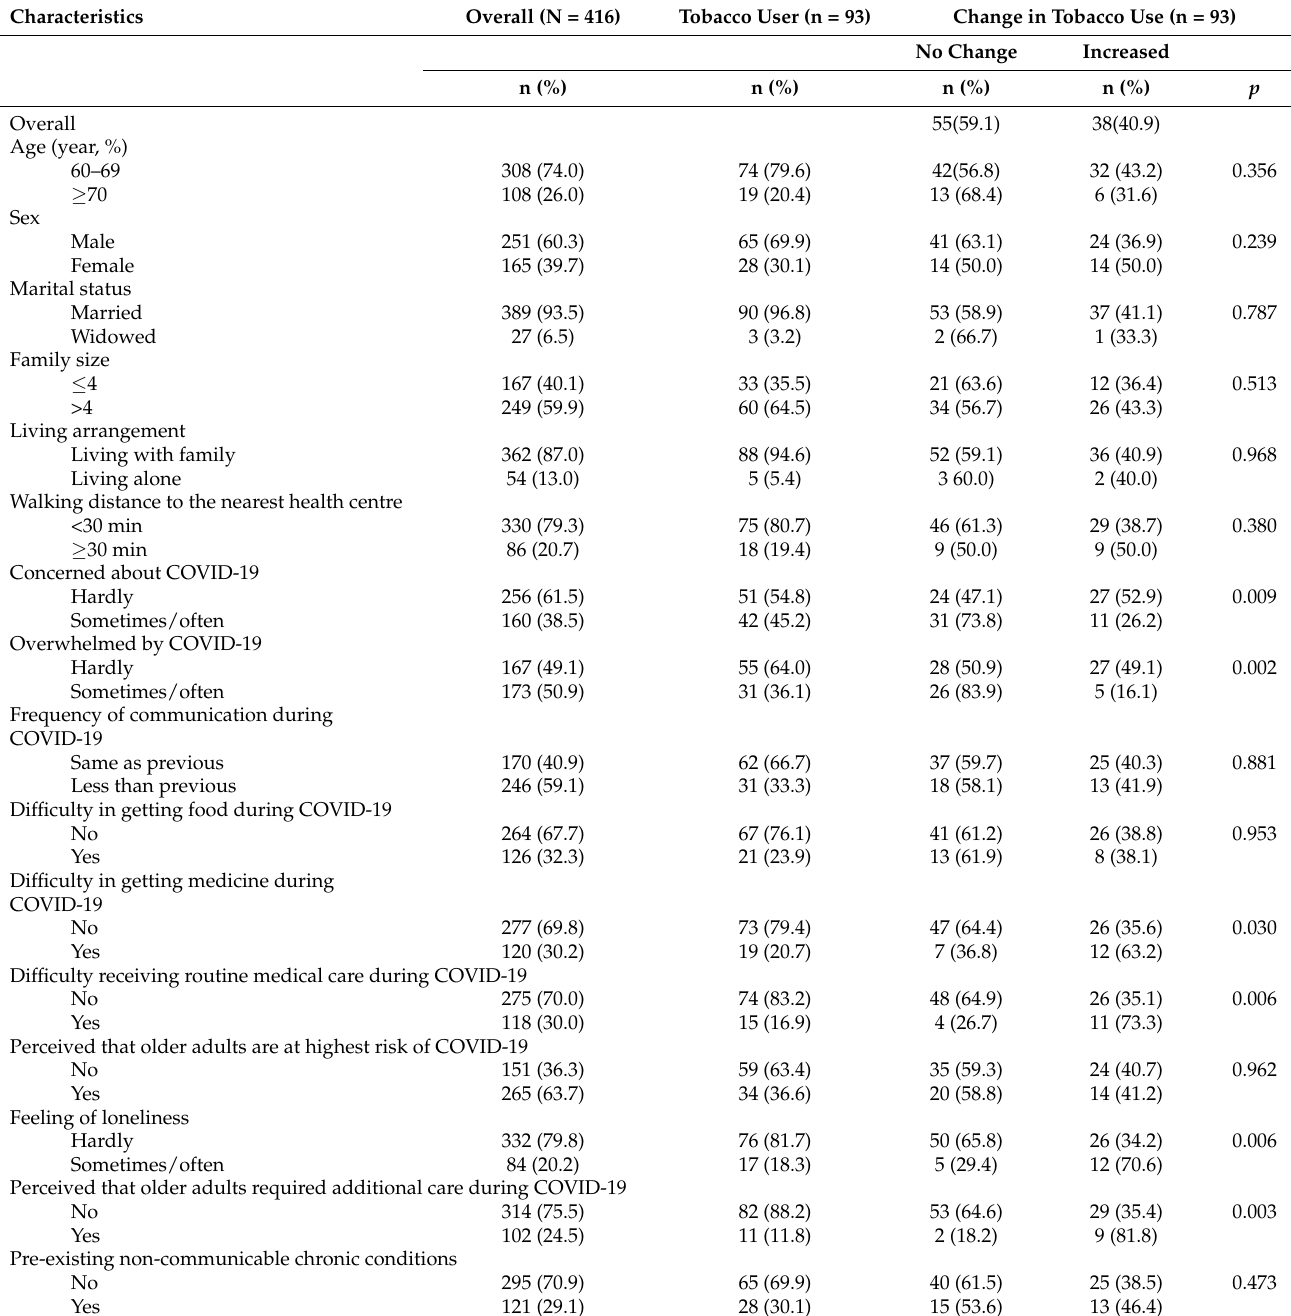
Table 1. Changes in frequency of tobacco consumption during COVID-19 (N =